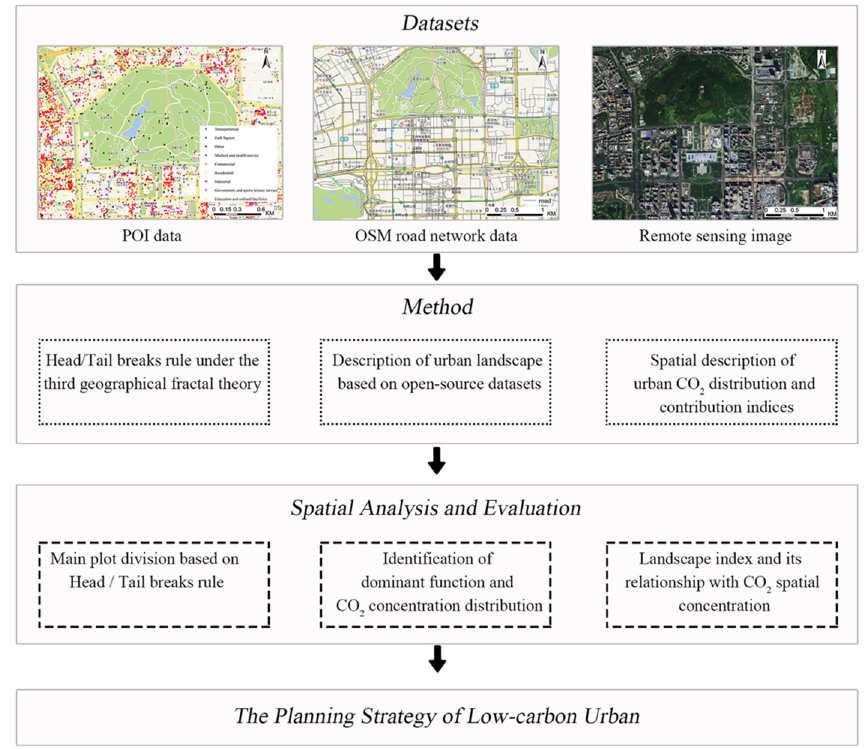
Figure 3. Overall framework.